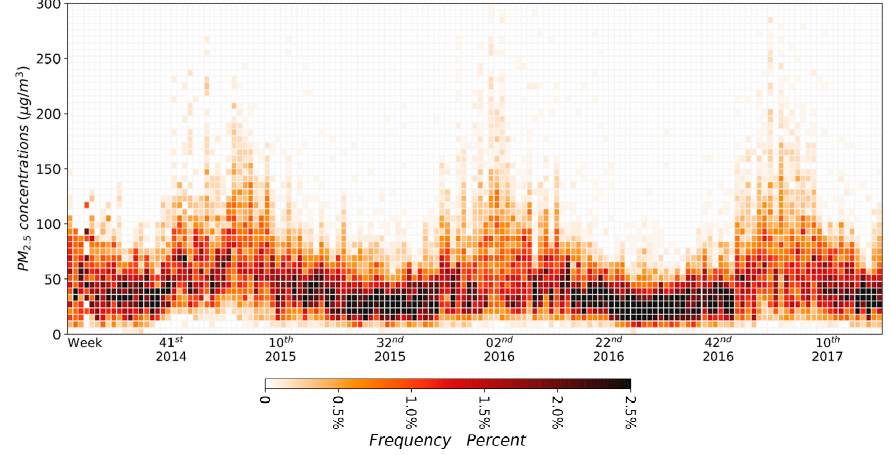
Figure 3. The time series thermodynamic histogram of PM 2.5 weekly average concentration distribution in 338 cities in mainland China.